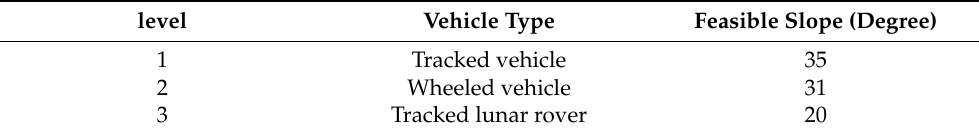
Table 1. Feasible slope thresholds corresponding to different